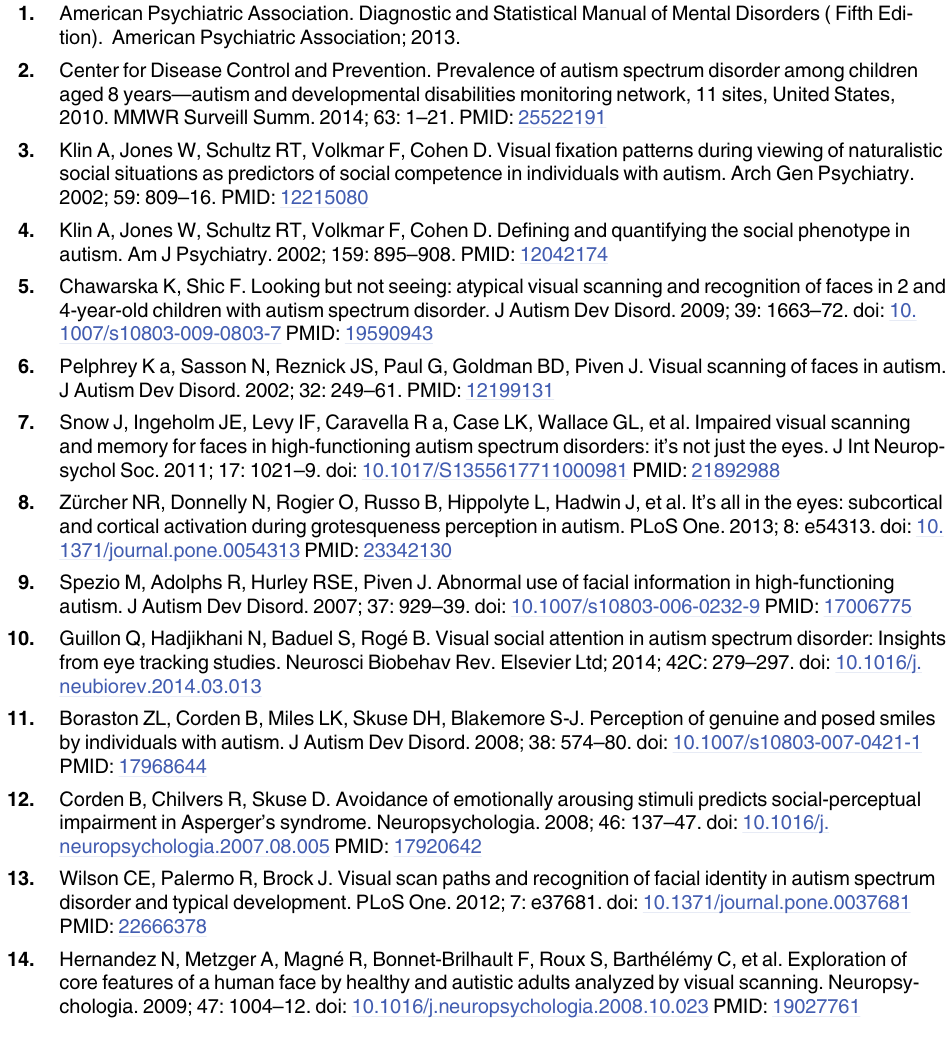
S1 Table. Individual data underlying the findings reported in this